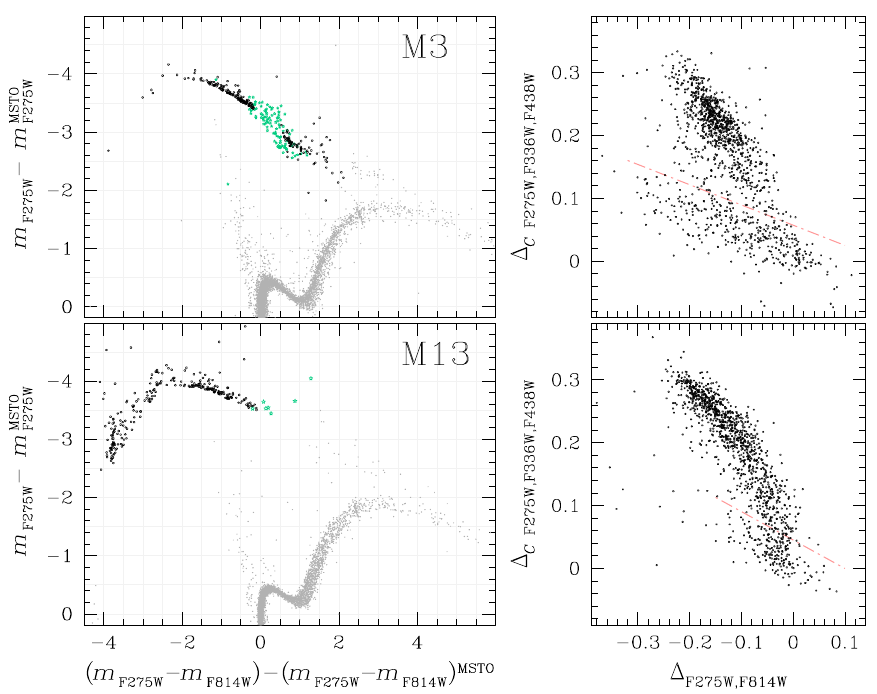
Figure 4. Comparison of the CMDs of M3 ( top left ) and M13 ( bottom left ). For comparison purposes, stellar colors and magnitudes are normalized to the corresponding values for the MS turn off. HB stars are represented with black dots, while variable stars are marked with aqua starred symbols. The ChMs of RGB stars of M3 and M13 are plotted in the top-right and bottom-right panel, respectively. The red dotted lines separate the bulk of 1P and 2P stars. This figure is derived by using photometry from Milone et al.